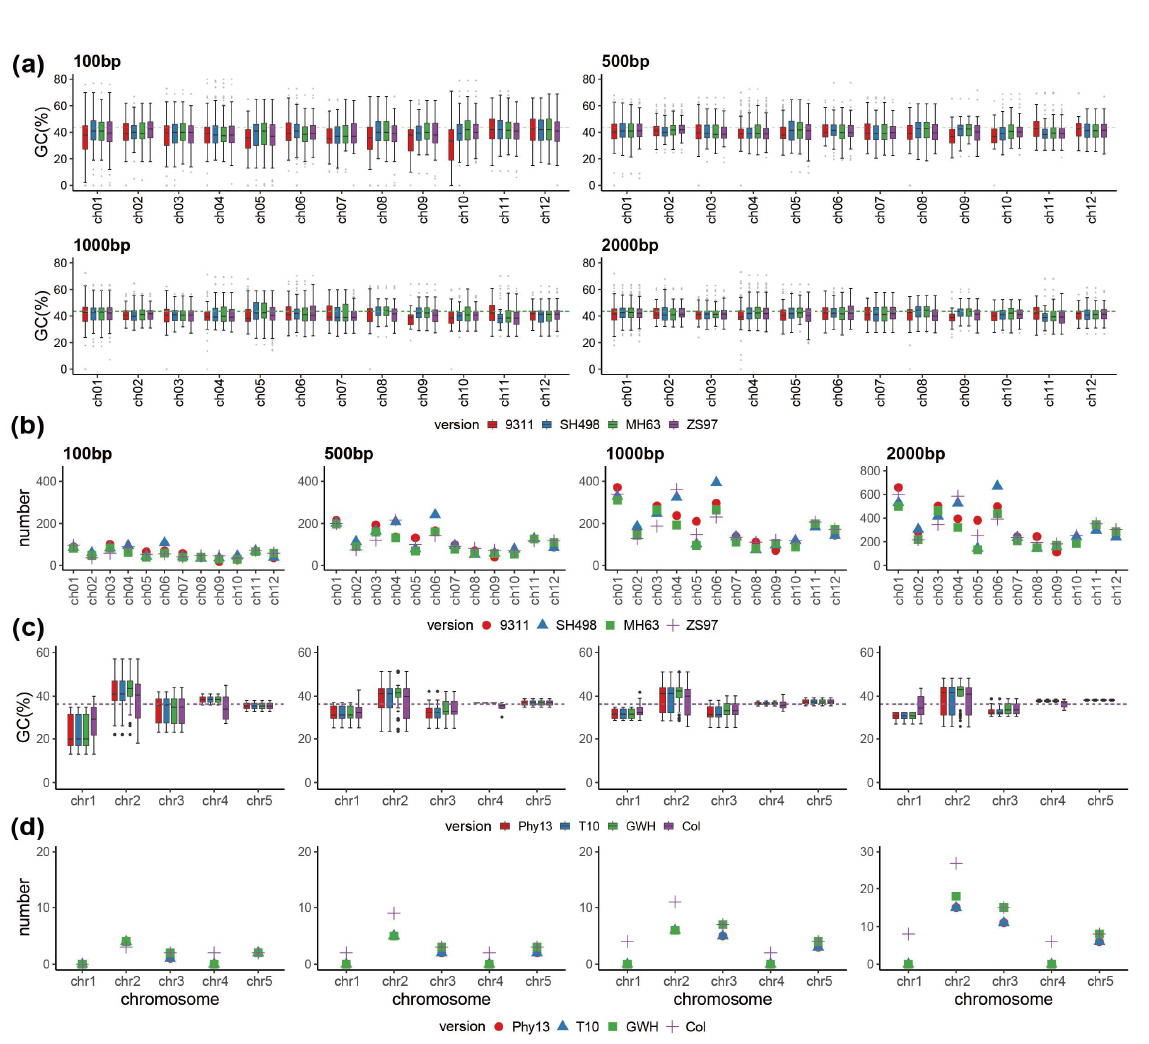
Figure 2. The GC and TE (transposable element) content in flanking sequences around plastome transferred sequences. ( a , c ) The GC content of flanking sequences by size category and assembly version in O. sativa and A. thaliana , respectively. ( b , d ) The number of TEs in flanking sequences by size category and assembly version in O. sativa and A. thaliana , respectively.